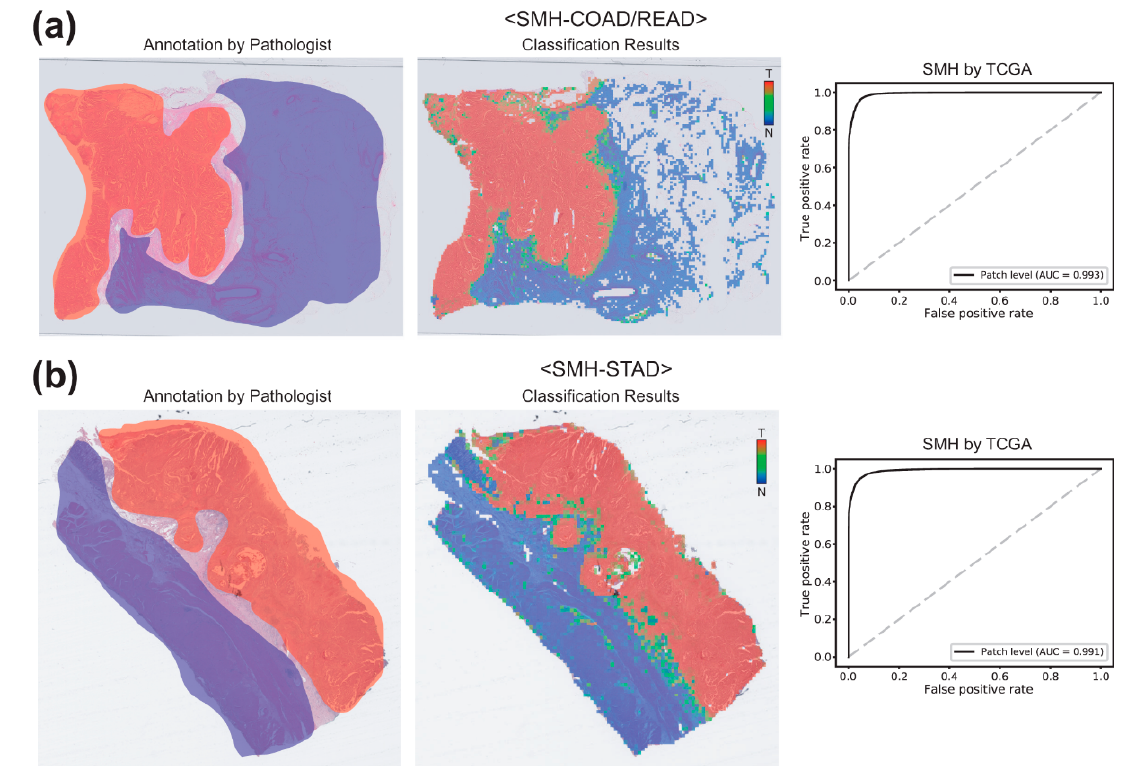
Figure 5. Classification results for the SMH-COAD/READ and SMH-STAD datasets by the classifiers trained on the TCGA-COAD/READ and TCGA-STAD datasets, respectively. ( a ) Results for the SMH-COAD/READ dataset. For a representative formalin-fixed paraffin-embedded (FFPE) WSI, both pathologists’ annotation and the heatmap result were presented for the comparison (left two images). Then, receiver operating characteristic (ROC) curve for the classification results was presented. ( b ) Same as ( a ), but the results were for the SMH-STAD dataset.